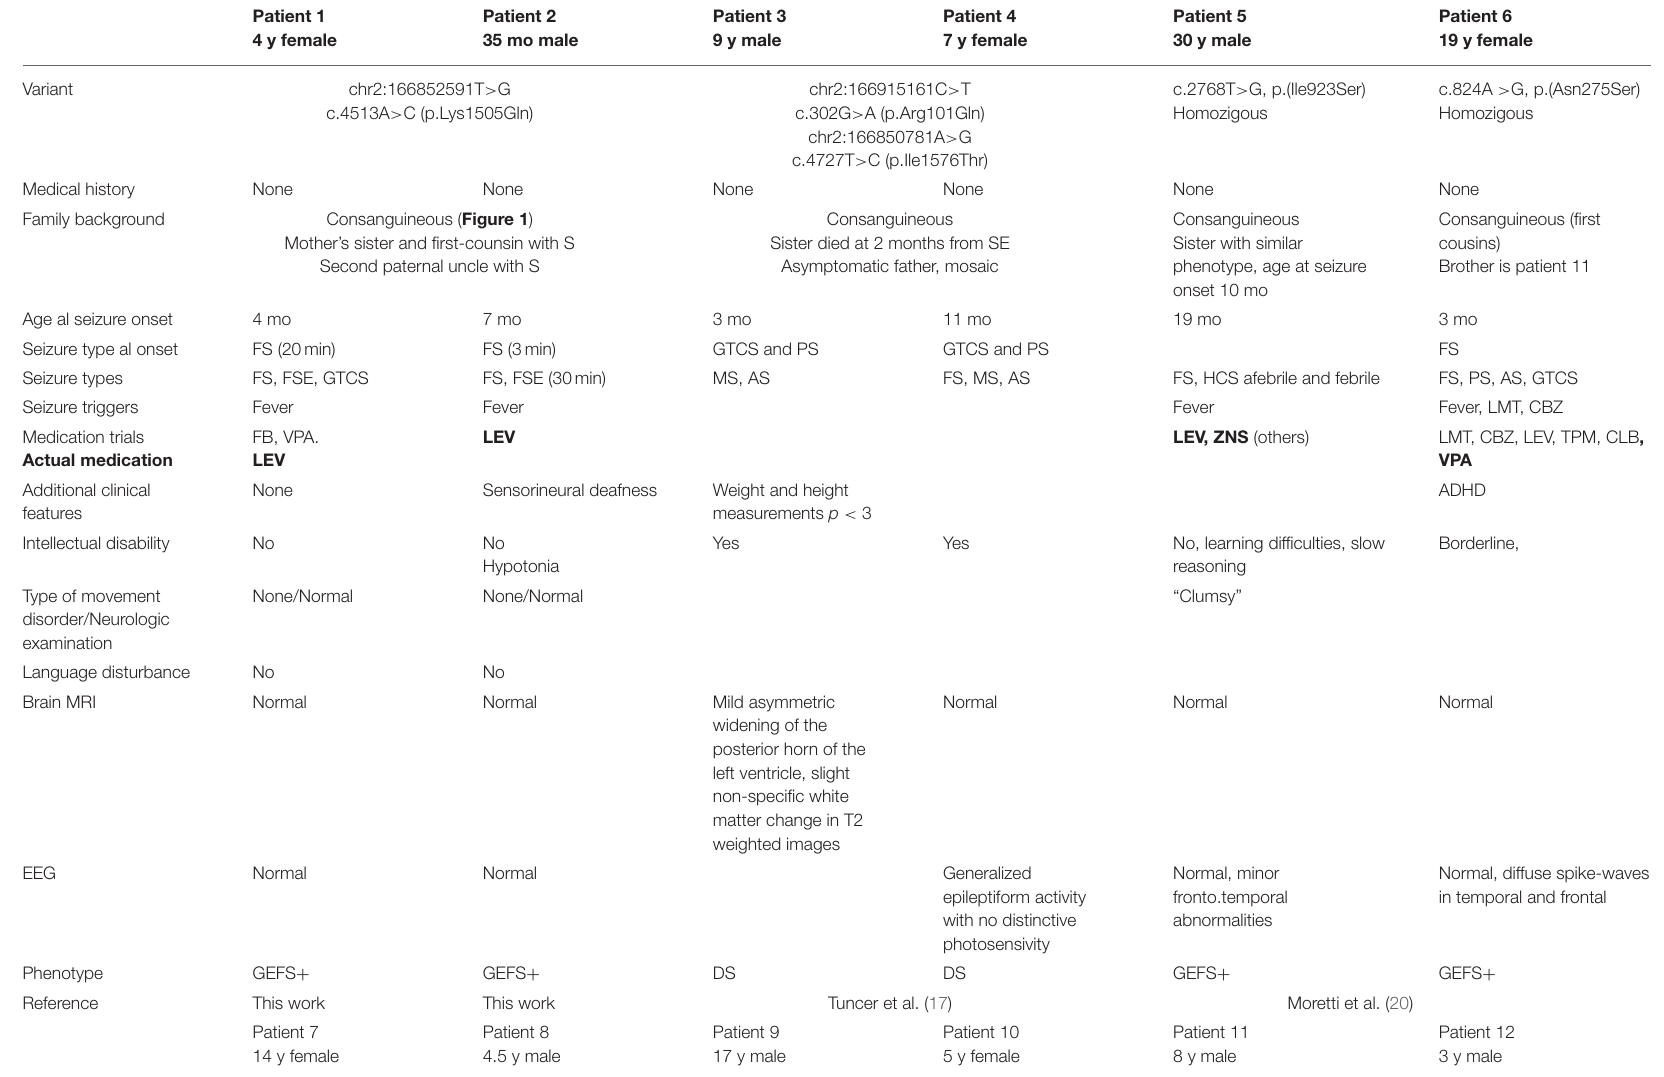
TABLE 1 | Clinical information on 12 patients with pathogenic or likely pathogenic SCN1A variants with autosomal recessive inheritance NM_001165963.1 (see Figure 2